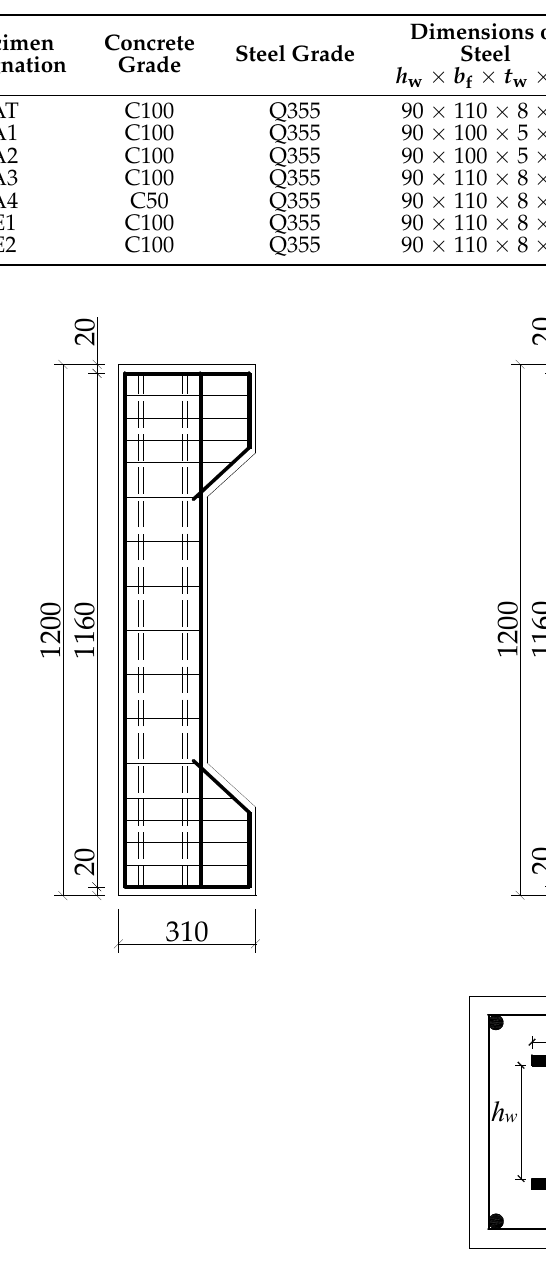
Table 1. The key parameters of the columns.